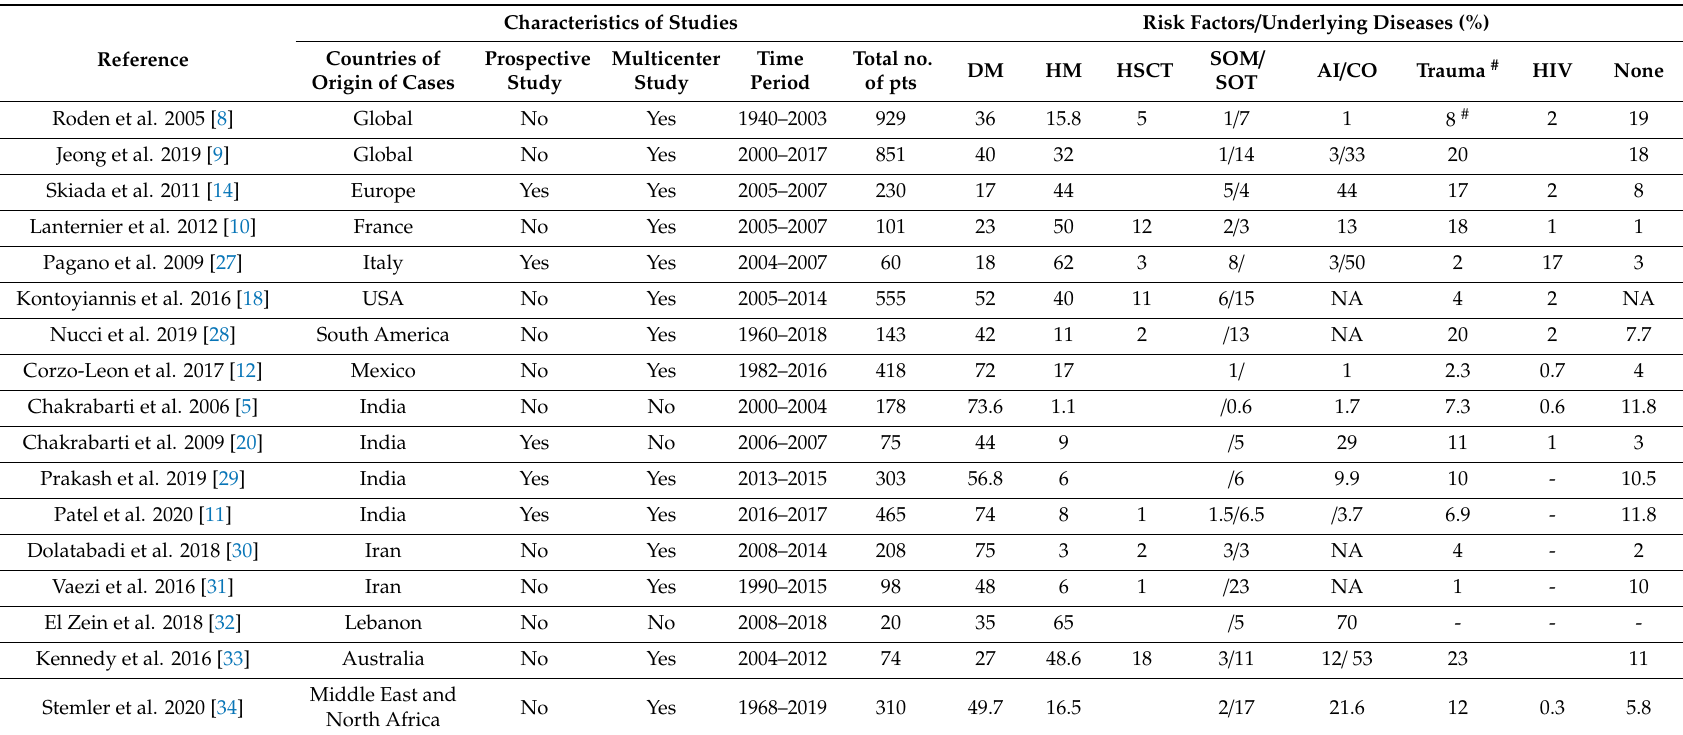
Table 2. Risk factors for mucormycosis. In several studies there are multiple risk factors so the total is more than